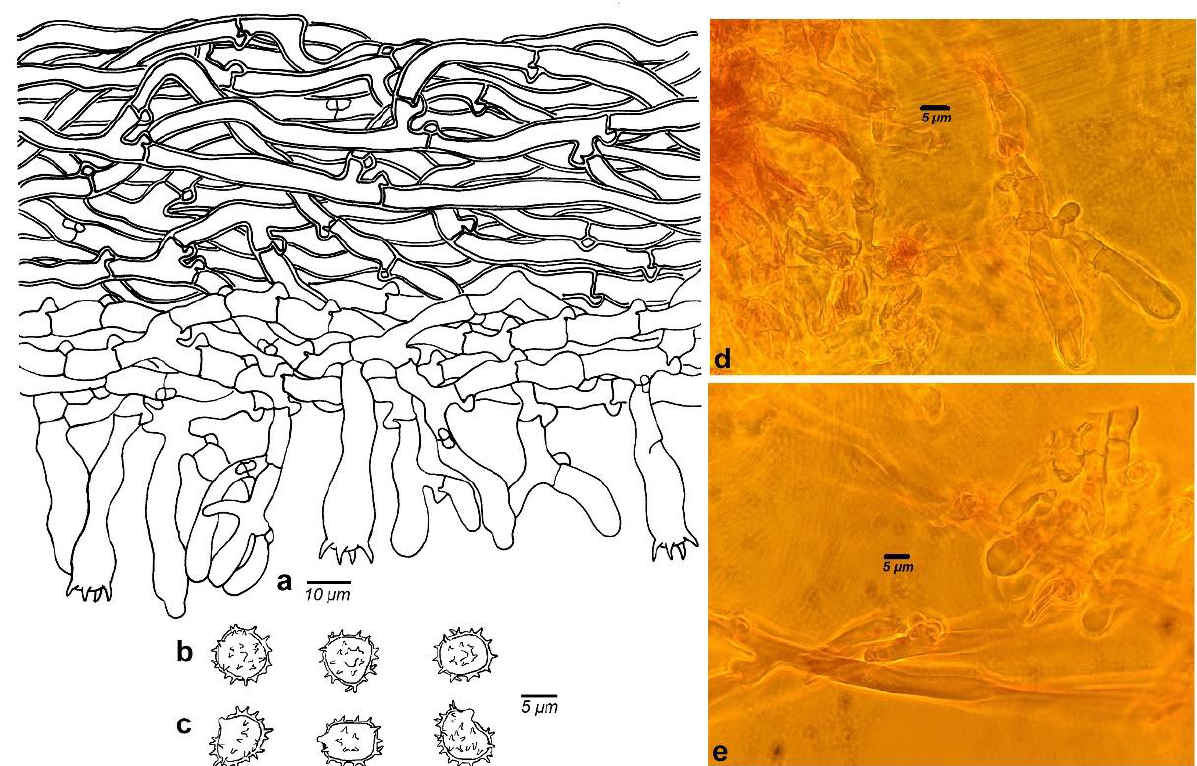
Figure 4. Microscopic structures of Tomentella aurantispora (drawn from holotype Yuan 14268). ( a ) A section through basidiocarp. ( b ) Basidiospores in frontal view. ( c ) Basidiospores in lateral view. ( d ) Optical microscope images of subhymenial hyphae. ( e ) Optical microscope images of subicular hyphae and basidia.